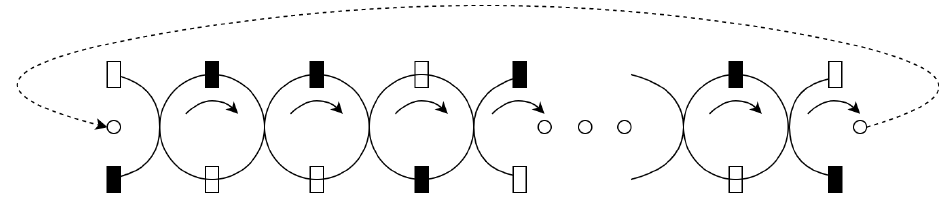
Figure 1. Binary chain equivalent to ECA